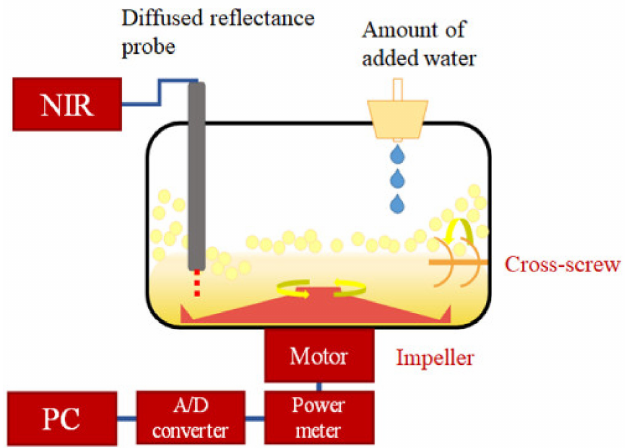
Figure 1. Schematic diagram of the high-speed stirring granulator with the near-infrared spectral monitoring